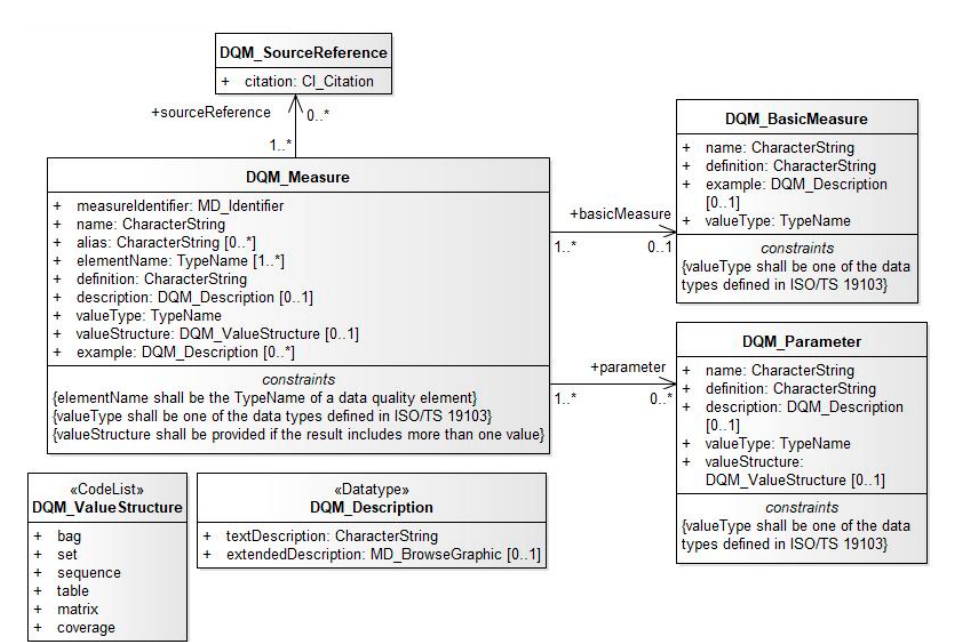
Figure 7. ISO 19157 Components of a data quality measure. Table 7. Standardized data quality measure—number of missing connections due to undershoots.